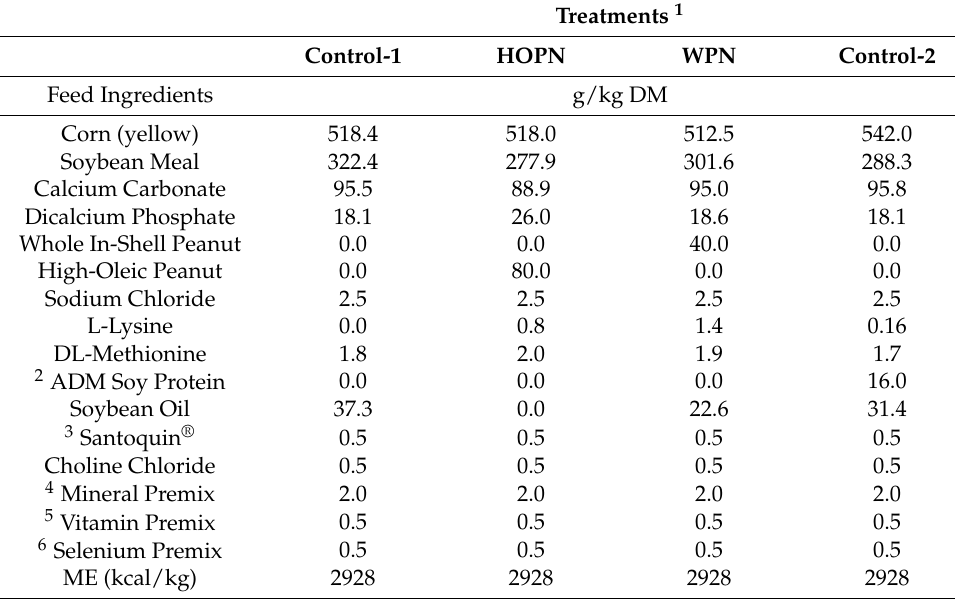
Table 1. Composition of formulated experimental laying hen